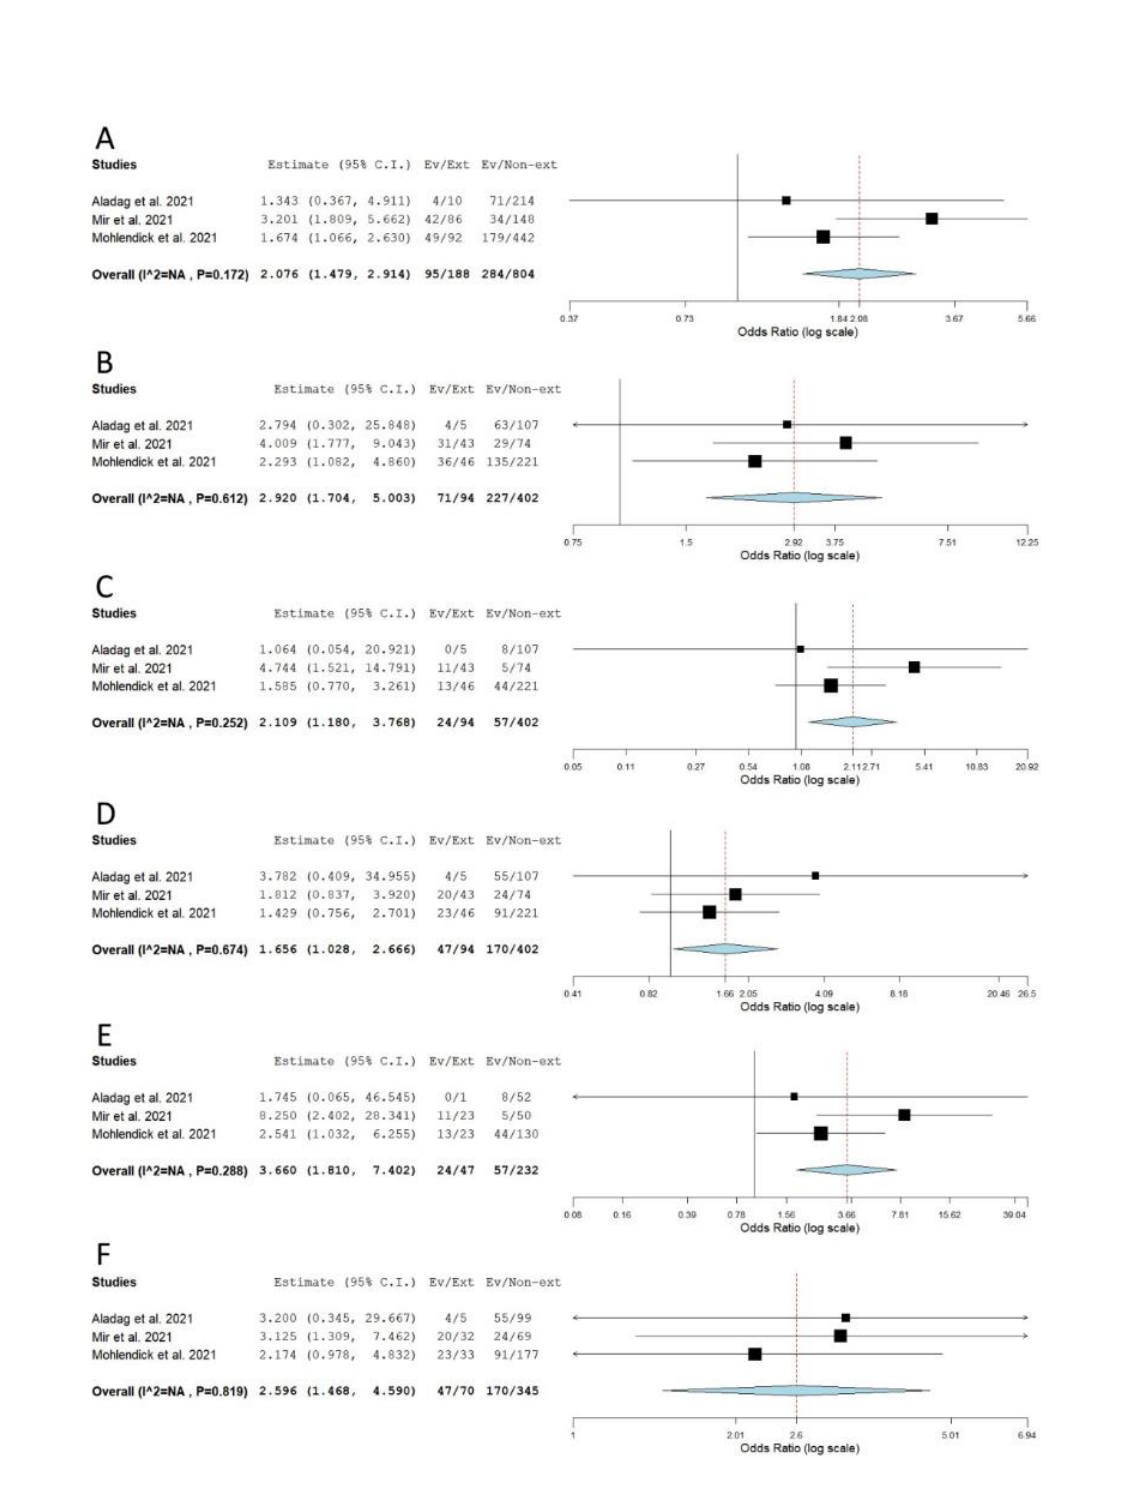
Figure 5: Meta-analysis of the association between rs1799752 in ACE1 and COVID-19 outcome in hospitalized patients: comparison exitus vs. survivors. A ) allelic model; B ) dominant model; C ) reces- sive model; D ) overdominant model; E ) II vs. DD; F ) DI vs. DD. The results of the included studies presented as ORs, with 95 % CI, and the overall effect with 95 % CI are shown in the forest plot. P values given are derived from heterogeneity